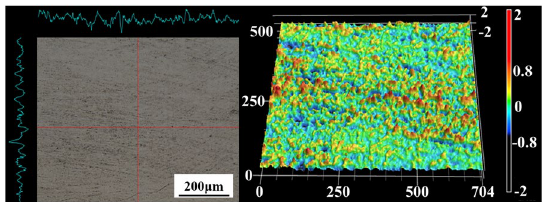
Figure 8 Surface morphology and 3D display of the SLMed/HSMed samples